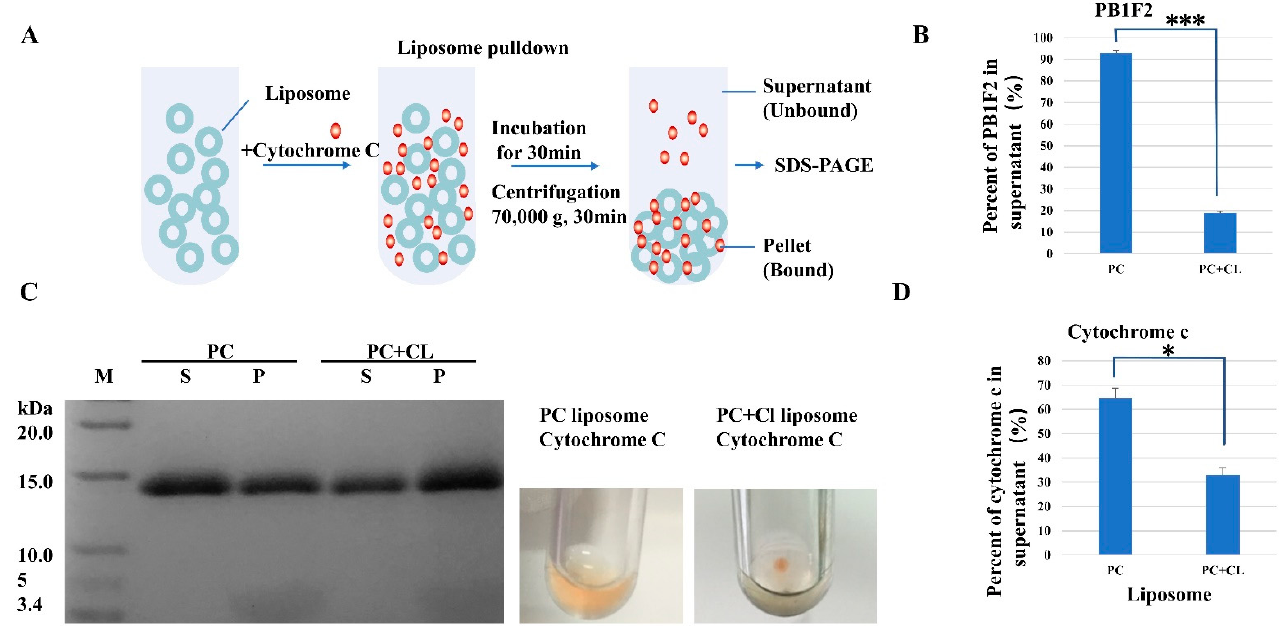
Figure 1. Characterization of the phospholipids binding specificity of Cytochrome C. ( A ) schematic diagram of the liposome pulldown assay; ( B ) BCA assay results of lipsosome pull down of PB1F2; ( C , D ) SDS-PAGE and quantification of liposome pulldown results of Cytochrome C. Liposomes were incorporated with POPC (PC) or POPC and cardiolipin (PC+Cl). Liposomes (1 mg/mL) and cytochrome c (0.2 mg/mL) were incubated at room temperature for 30 min. After ultracentrifuga- tion, the pellet (P) and supernatant (S) were analyzed by SDS-PAGE. Data were pooled from three independent experiments, and the results were represented as mean ± SD. * p < 0.05, *** p < 0.001.